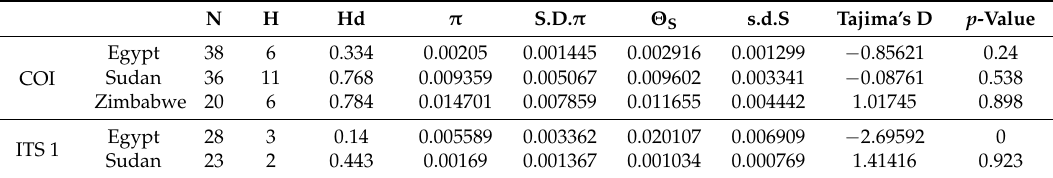
Table 2. Estimation of nucleotide diversity and summary statistics of Bulinus truncatus identified using COI I and ITS 1